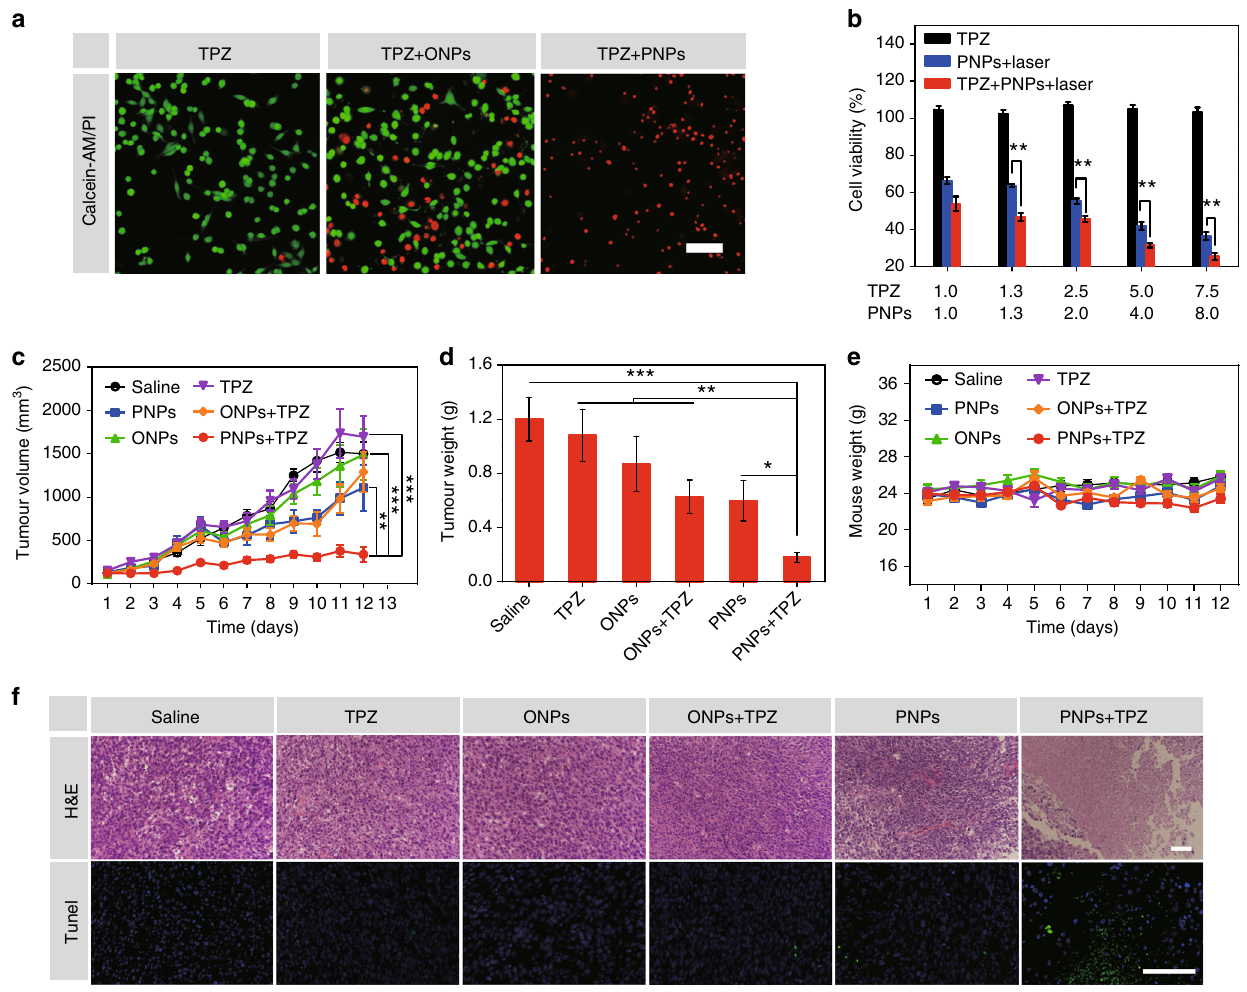
Fig. 4 PNPs enhanced TPZ chemotherapy. a Fluorescence images of CT26 cells cultured with TPZ and oil nanoparticles (ONPs) or PNPs under laser irradiation (808 nm, 400 mW cm − 2 ). Viable cells were stained with Calcein-AM (green), and dead/late apoptotic cells were stained with propidium iodide (PI) (red), (scale bar, 100 μ m). b Viability of treated cells ( n = 3). c Tumour growth curves of treated mice ( n ≥ 6 per group). Both PNPs and TPZ were injected intravenously into mice on days 1, 3 and 5. Tumours in groups 3, 4, 5 and 6 were irradiated three times (808 nm, 400 mWcm − 2 ) for 5 min at 24 h after the administration of the PNPs. d Normalized averages of the tumour weight on day 12. e Changes in body weight. f Haematoxylin and eosin (H&E) (scale bars, 100 µ m) and terminal deoxynucleotidyl transferase dUTP nick-end labelling (TUNEL) (green) (scale bars, 100 µ m) staining of CT26 tumour sections. Samples were collected from different groups on day 8 post administration. Data are presented as the mean ± s.e.m. * p < 0.05, ** p < 0.01, *** p < 0.001 (unpaired, two-way t tests). Source data are provided as a Source Data